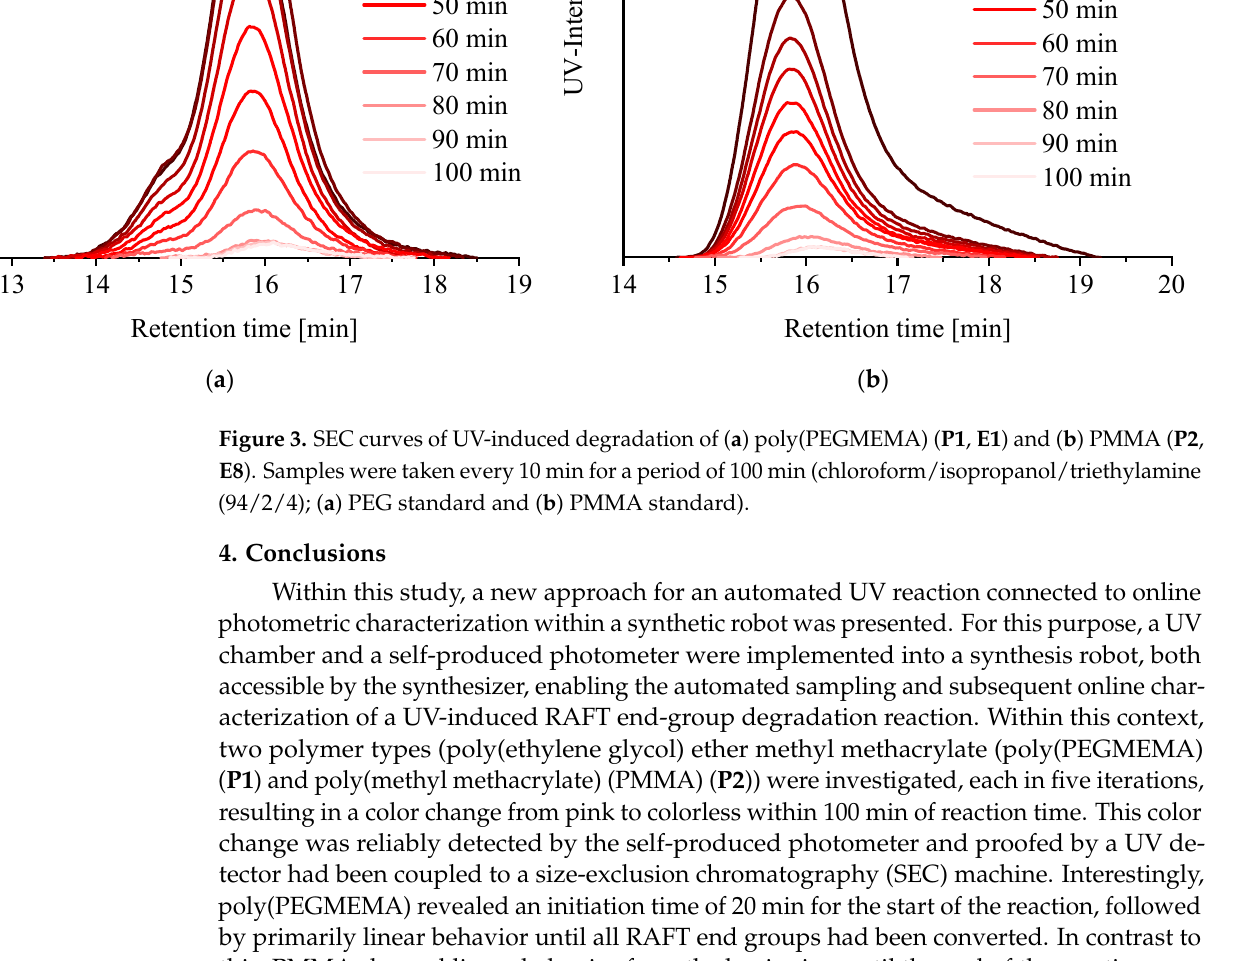
( b ) Figure 2. Diagram of photometric measurements of UV-induced degradation of ( a ) poly(PEGMEMA) ( P1 , E1–E5 ) and ( b ) PMMA ( P2 , E6–E10 ). Samples were taken every 10 minutes for a period of 100 min. Each experiment was fitted utilizing a cubic polynomial fit.